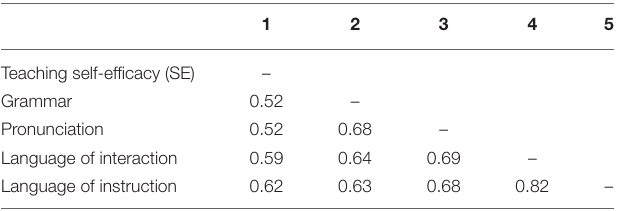
( Table 3 ). The results show that the overall level of teaching self- efficacy was significantly predicted by language of instruction (